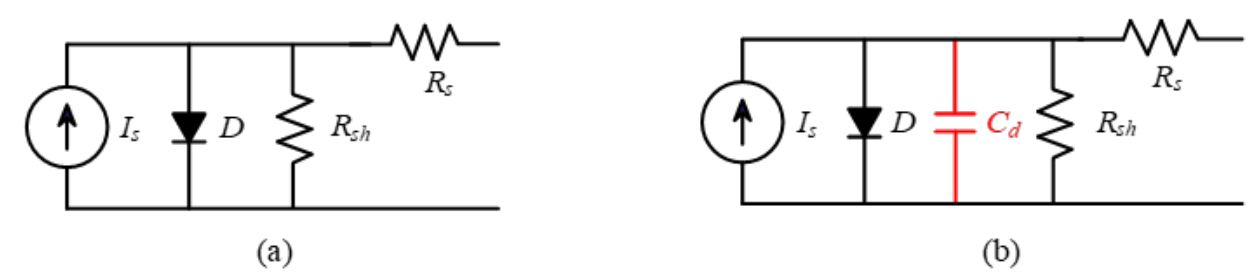
Figure 6. A photovoltaic (PV) solar cell model: ( a ) without diffusion capacitance; ( b ) with diffusion capacitance. Here, Cd is the diffusion capacitance, D is the anti-parallel diode, Rs is the series resistance, and Rsh is the shunt resistance.